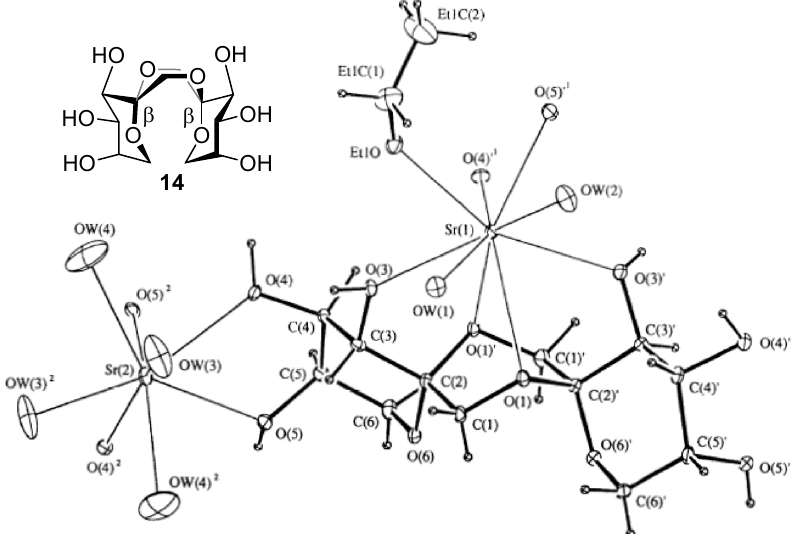
Figure 5. X-Ray structure of the Sr 2+ − di- β -fructopyranose-1,2’:2,1’-dianhydride ( 14 ) complex (reproduced from reference [53], with permission of NRC Research